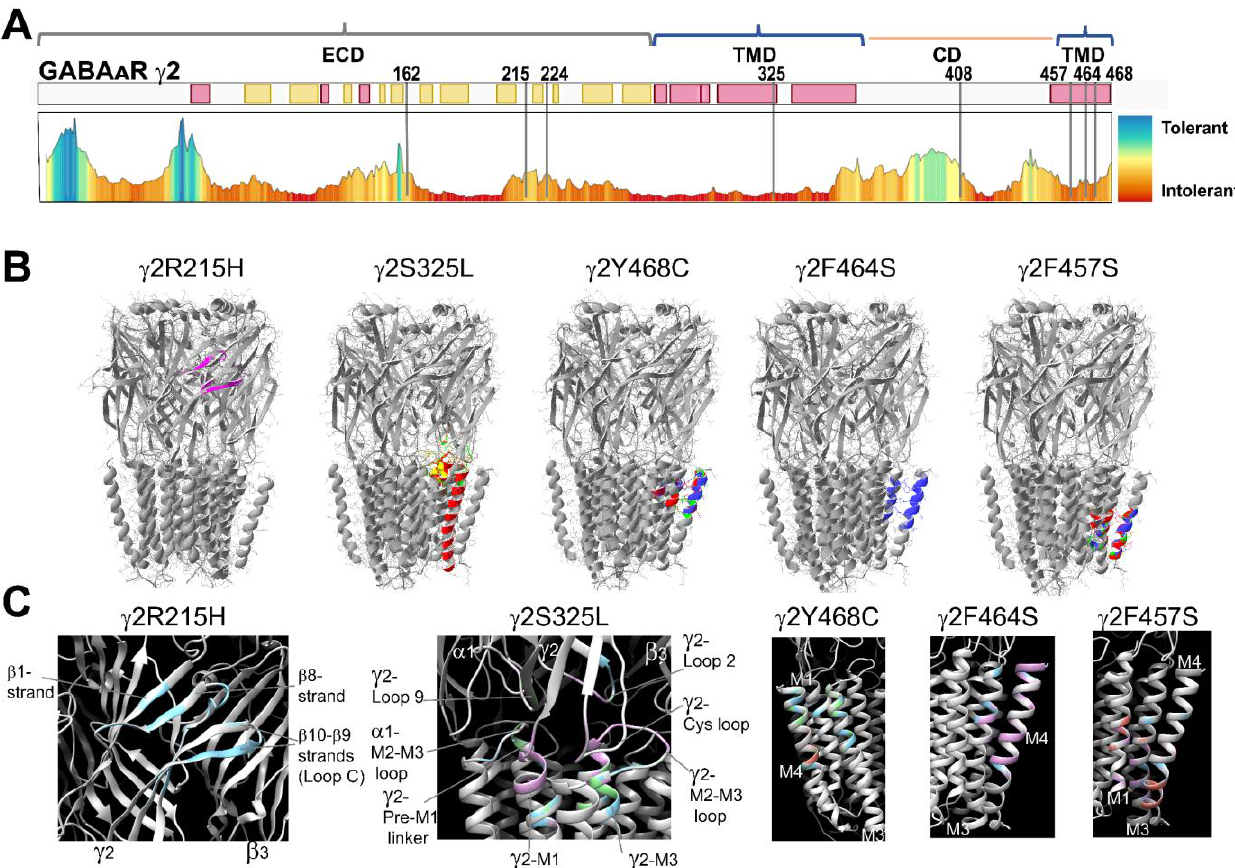
Figure 2. Mutant γ2 subunits induced structural rearrangements in structural domains important for GABA A receptor gating. ( A ) GABA A R γ2 tolerance landscape schematic representation of γ2 protein domains that did not tolerate missense variants. As shown, non-tolerated highly pathogenic variations shift the color gradient towards red, whereas tolerated variations with low pathogenicity shift the color gradient towards blue. Elements of the secondary structure of the GABA A R γ2 subunit are shown in yellow (β - strands) and red (α -helices) rectangles. Bracket symbols delimit the extracellular (ECD), transmembrane (TDM), and cytoplasmic domains (CD). All GABA A R γ2 subunit variants considered in this study were mapped to intolerant landscape regions. ( B ) Global structural perturbations shown on the Cryo-EM 6HUO structure after introduction of single point mutations in the γ2 subunit at positions 215, 325, 468, 464, and 457. The structural rearrangements in the secondary structure and side chain residues that differ among the WT (in gray) and the mutant simulation (RMS deviation ≥ 0.5 Å) are indicated in a different color from the WT simulation. ( C ) Enlarged views of structural domains showing structural rearrangements produced by the γ2R215H, γ2S325L, γ2Y468C, γ2F464S , and γ2F457S mutant subunits. Structural perturbations with RMS deviation ≥ 0.5 Å are shown and the conformational impact of the γ2 mutations to the α1β3γ2 GABA A R are indicated. WT, wild type; RMS, root mean square.